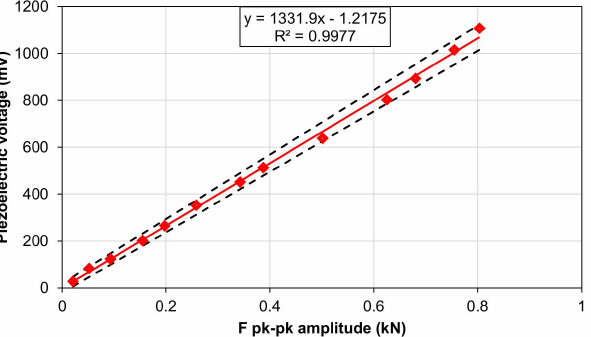
Figure 12. Output voltage of the piezoelectric sensor for increasing compressive forces, with C load = 470 pF and R load = 1 G Ω